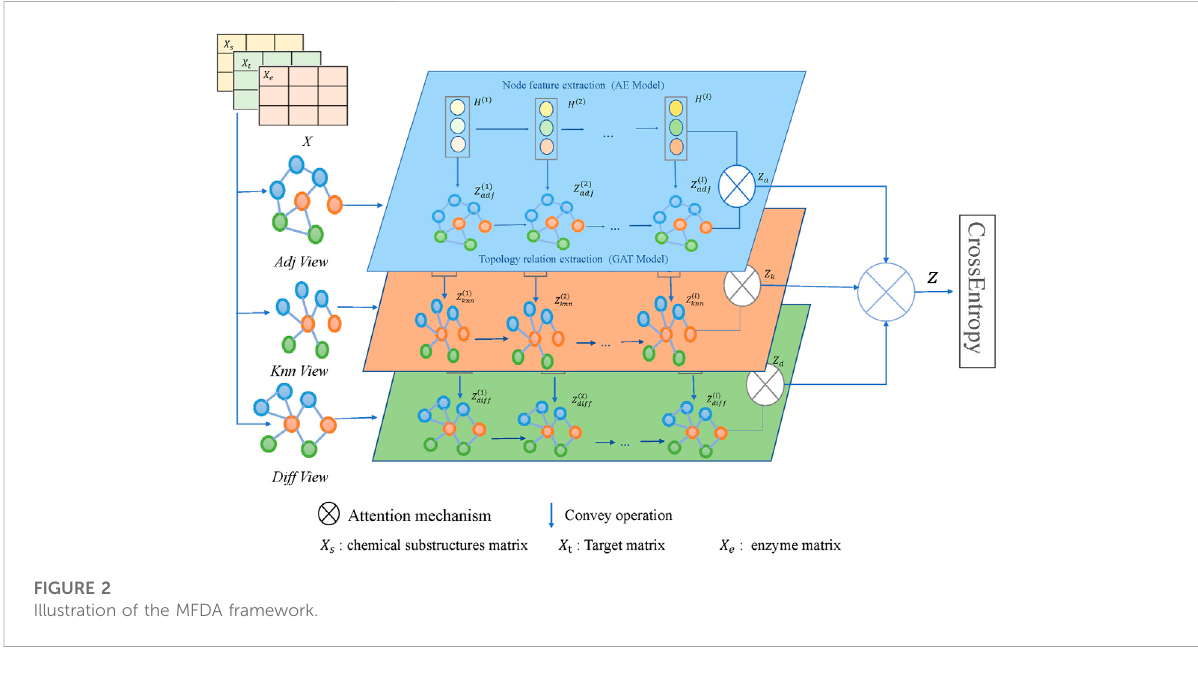
FIGURE 2 Illustration of the MFDA framework.